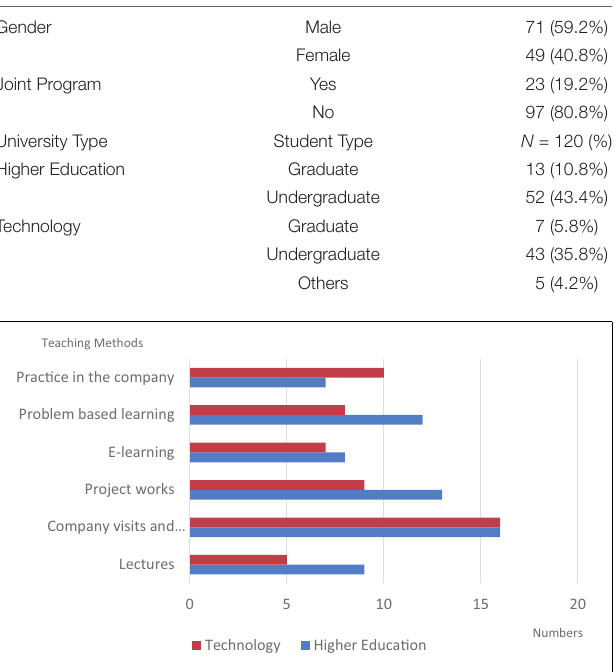
FIGURE 2 | Favorite teaching methods in different type